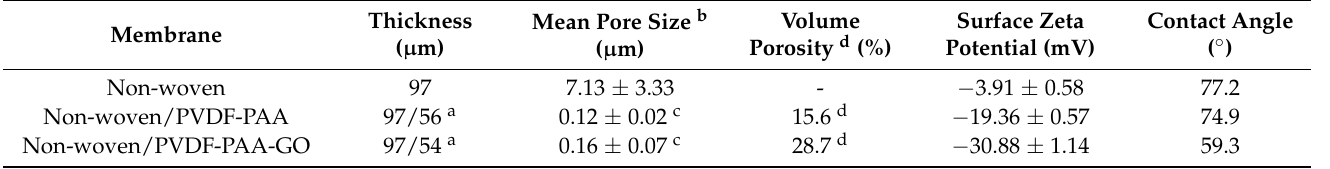
Table 1. Water contact angle, zeta potential, mean pore size, porosity, and thickness of non-woven PVDF, non-woven/PVDF-PAA, and non-woven/PVDF-PAA-GO composite membranes. Thickness Volume Surface Zeta Contact Angle Mean Pore Size b Membrane ( µ m) Porosity d (%) Potential (mV) ( ◦ ) ( µ m) Non-woven 97 Non-woven/PVDF-PAA 97/56 a a The numbers represent thicknesses for the non-woven support and top separation layer. b Data obtained